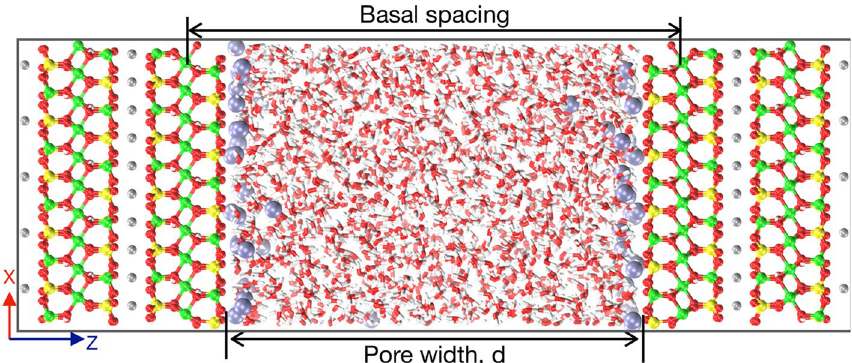
Figure 1. Simulation cell of mica pore containing two mica surfaces (on left and right) confining water molecules, and interstitial cations. The interlayer zone of width d is in equilibrium with bulk-reservoir of water (implicitly) which allows for exchange of water molecules between pore and reservoir. Color legend: Gray— potassium (K), red—Oxygen (O), green—aluminum (Al), yellow—silicon (Si), cyan—exchanged interstitial cation (i.e., either sodium, lithium or hydrogen ion) and